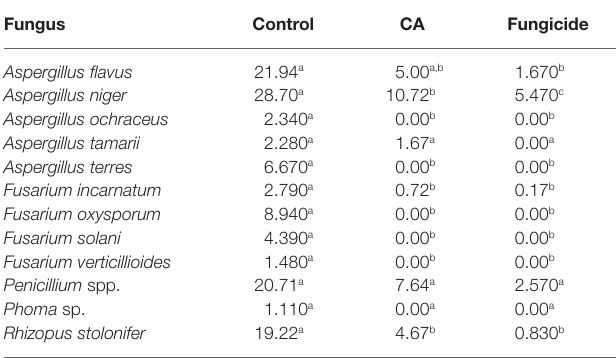
TABLE 4 | Mean initial values (%) of the incidence of fungi in peanut seeds as a response to CA treatment. Fungus Control CA Fungicide Aspergillus